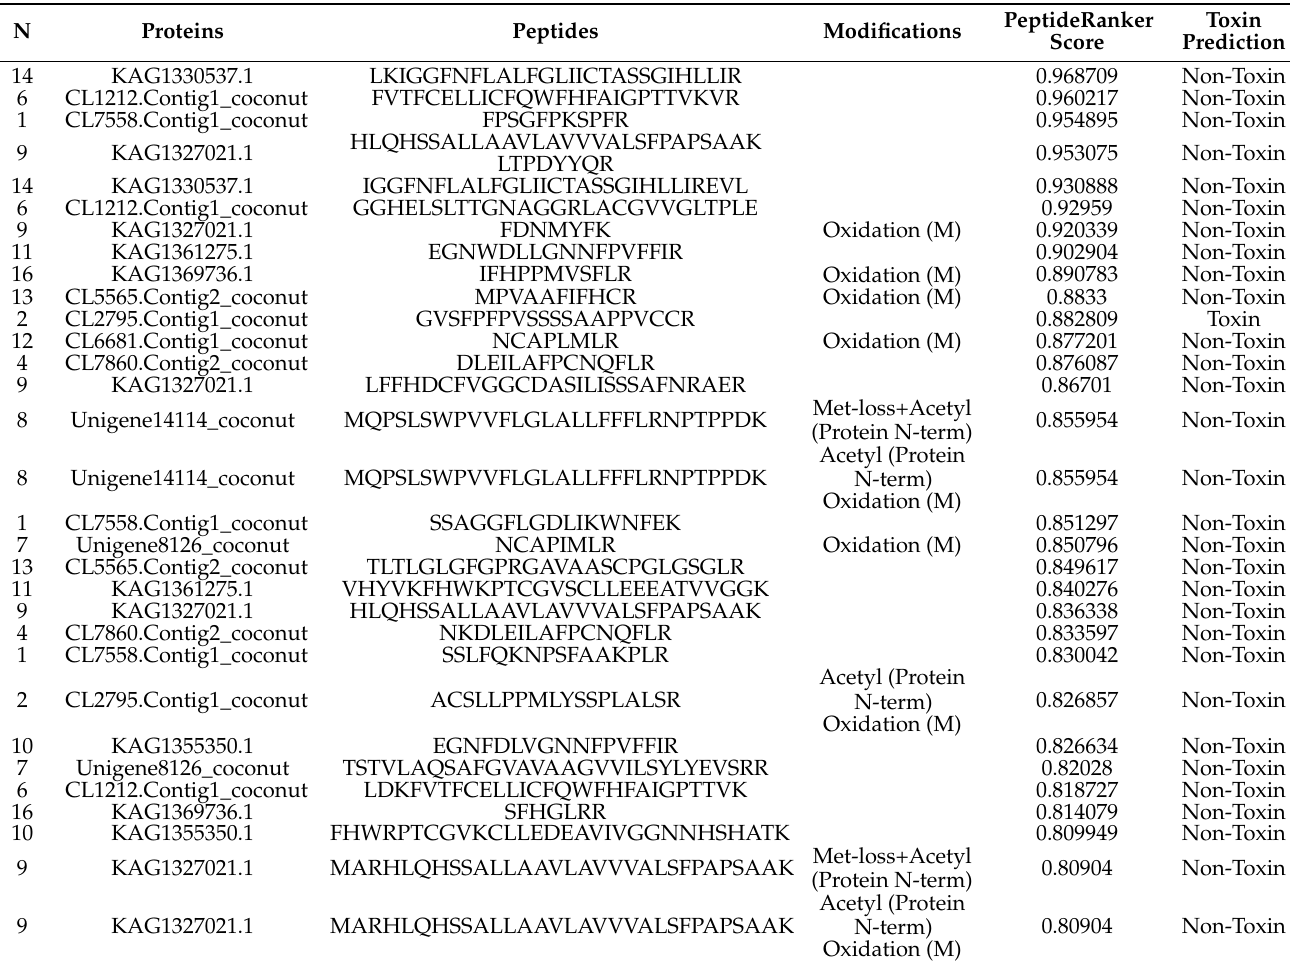
Table 6. Selected potential bioactive peptides of the antioxidant proteins predicted by in-silico digestions with